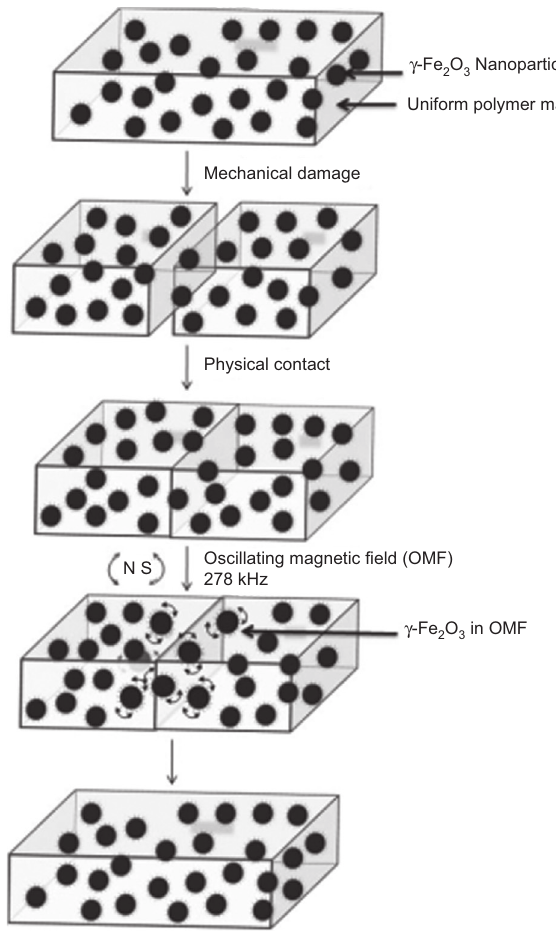
Figure 9 Schematic diagram of the self-healing mechanism of thermoplastic polymers in the presence of an OMF (reprinted with permission from [40]). Copyright 2009, John Wiley and